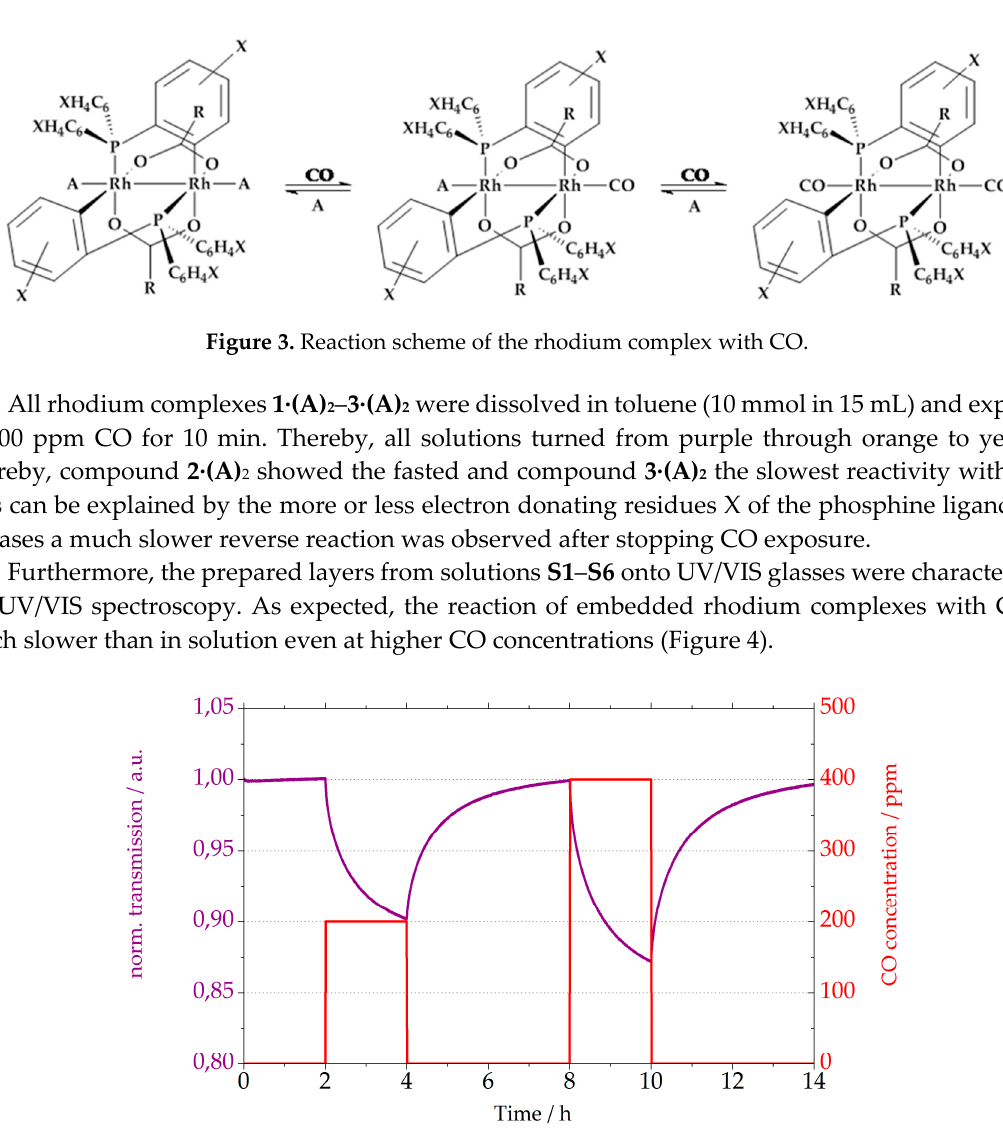
Figure 4. Normalized transmission change at 420 nm of 1 ∙ (A) 2 in EC ( S1 ) at 200 and 400 ppm CO